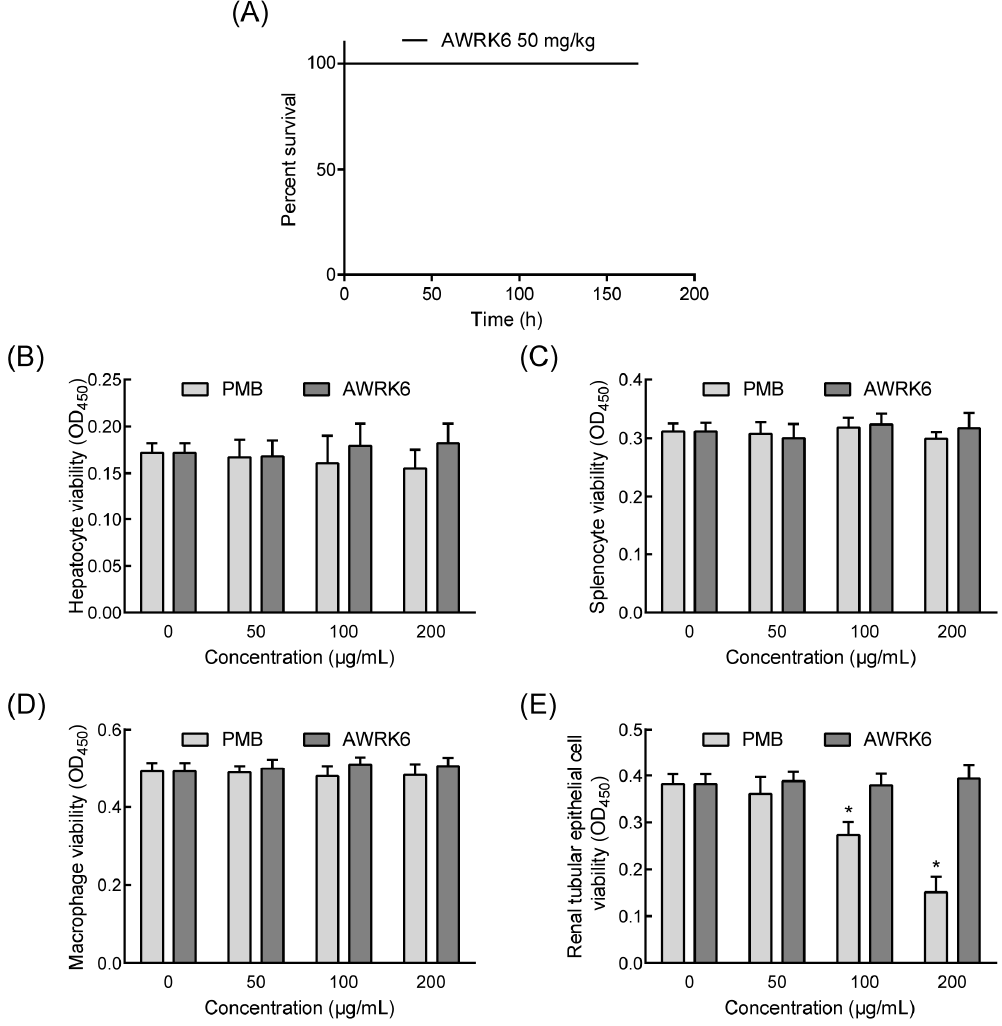
Figure 5. AWRK6 did not produce any significant toxicity in vivo and in vitro. ( A ) The survival curves of mice treated with a single dose of AWRK6 ( n = 10). ( B – E ) The cell viabilities of primary murine hepatocytes, splenocytes, macrophages, and renal tubular epithelial cells incubated with AWRK6 and PMB. * p < 0.05 compared with the 0 group.